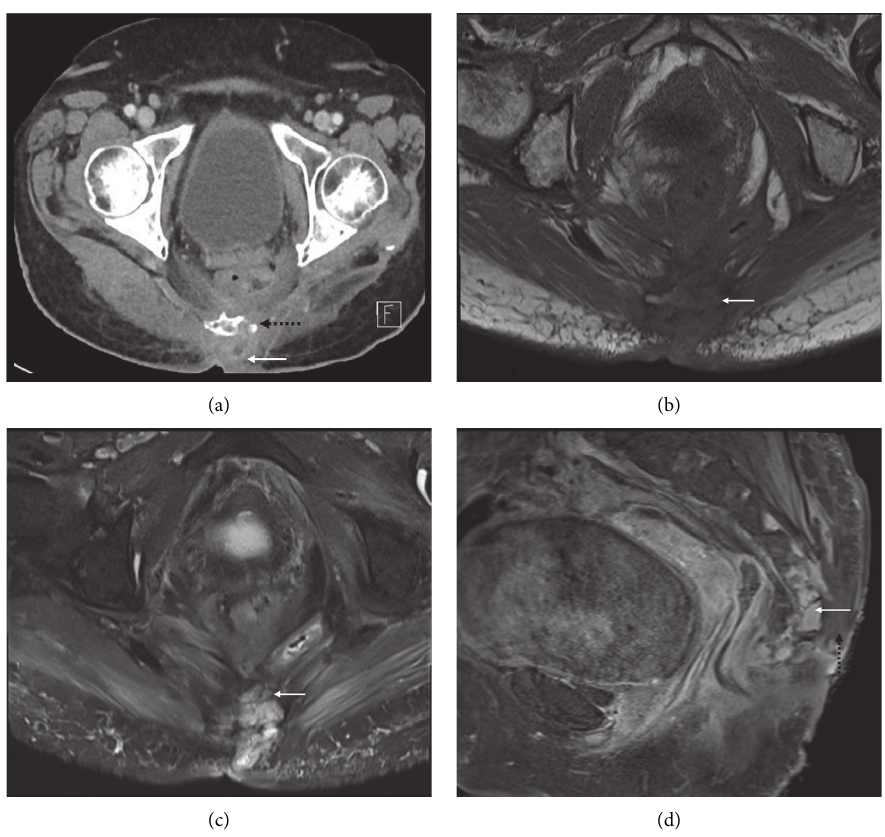
Figure 1: Osteomyelitis with an ulcer tract arising from a necrotic, infected pressure sore. Axial CTpelvis with intravenous contrast (a) of a 78-year-old bedbound female worked up for sepsis secondary to an infected pressure ulcer showed the ulcer extending to the coccyx in the left parasagittal region (arrow), with bone erosion (dotted line). The affected bone is hypointense on the axial T1 (b) and hyperintense on fluid-sensitive, PDFS (proton density with fat saturation, (c)) sequences. Sagittal T1FS postcontrast image (d) shows enhancement of the coccyx (arrow) and sacrococcygeal joint confirming the diagnosis. The adjacent deep subcutaneous region of nonenhancement is compatible with the area of necrosis (dotted arrow).